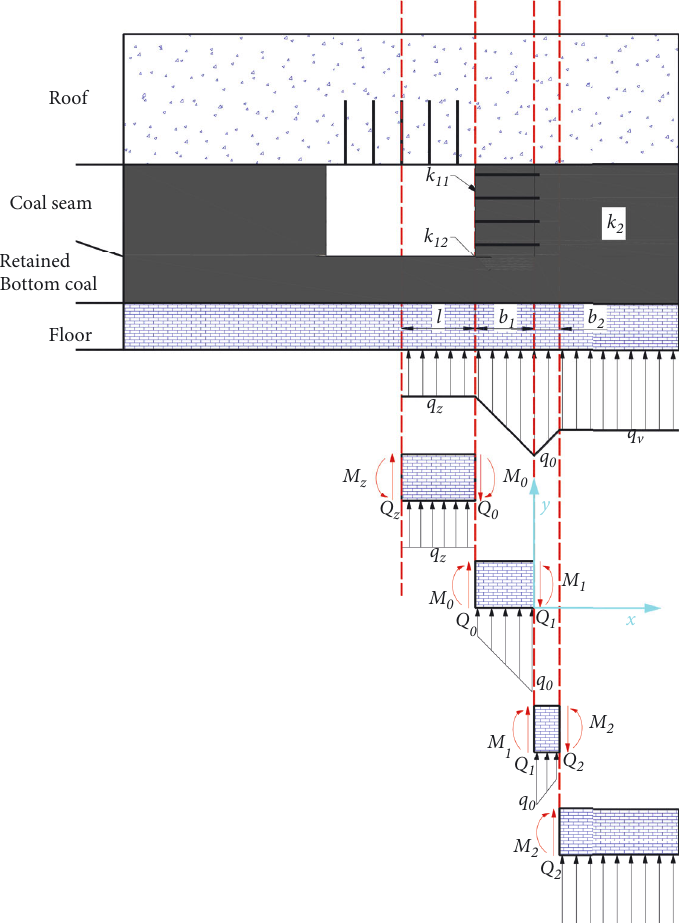
Figure 3: Reverse foundation model of the roadway fl